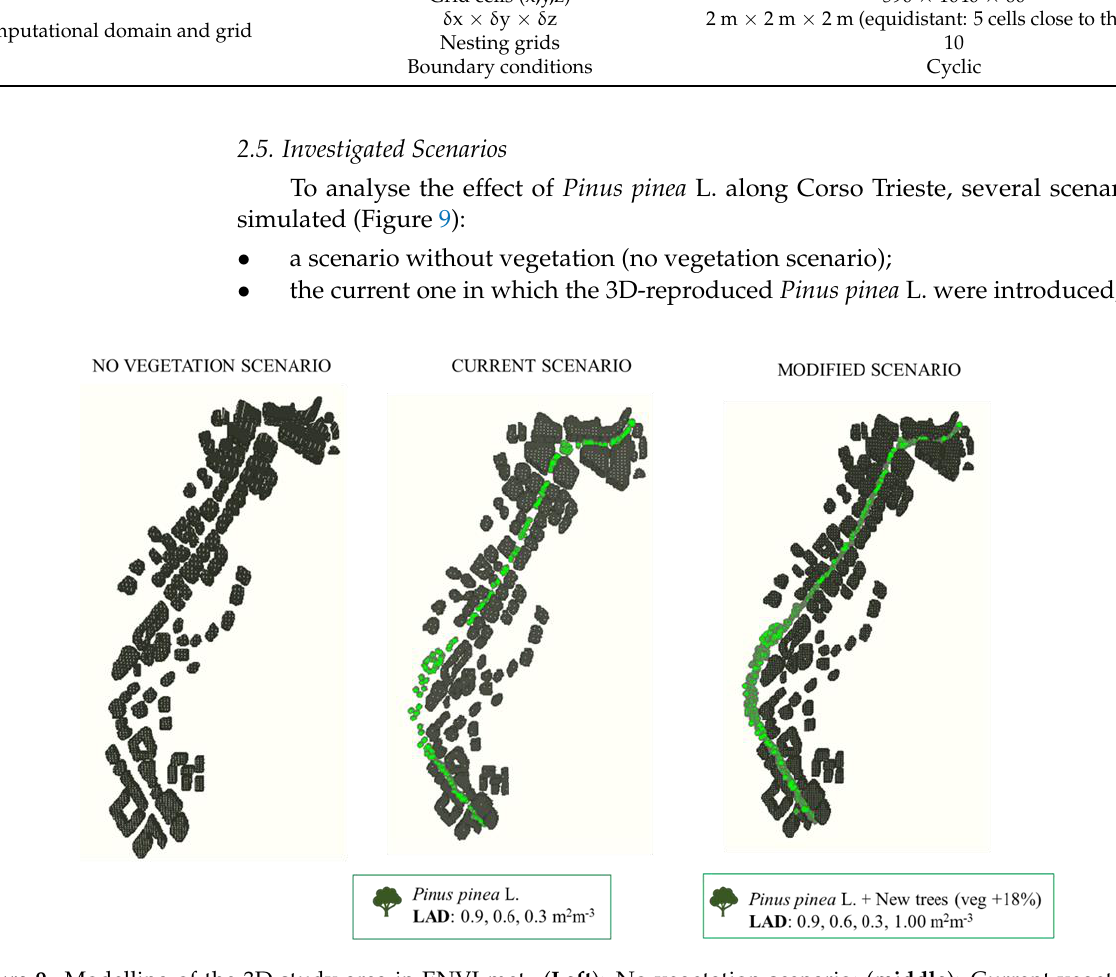
Figure 10. 3D geometry of the new tree model in the modified scenario.